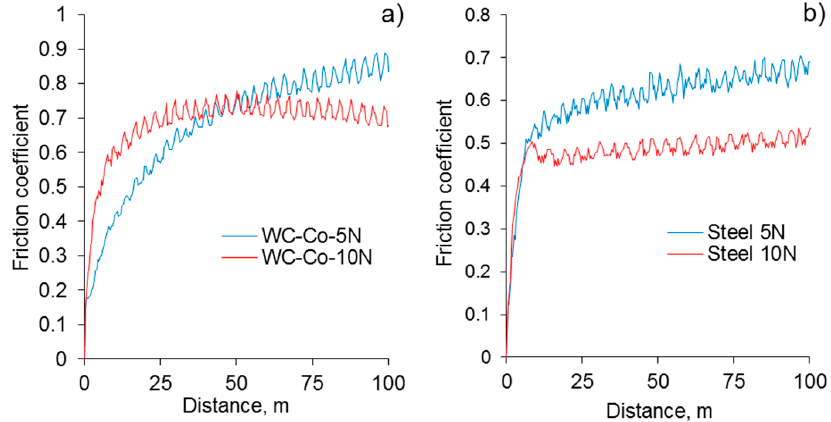
Figure 8. Evolution of the friction coefficient of the PEO coating with a residual thickness of 45 µm at normal loads of 5 and 10 N. Counterfaces are ( a ) WC-4%Co and ( b ) bearing steel.